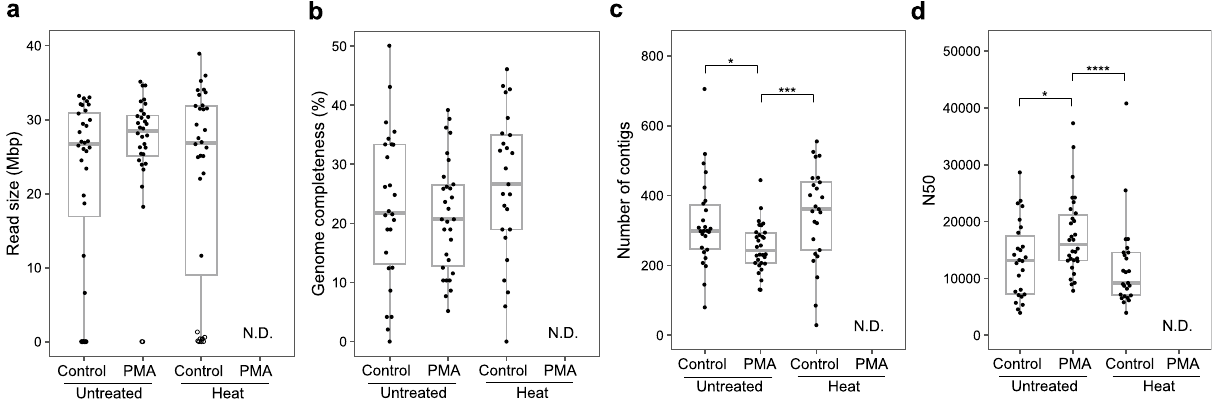
Figure 2. Effect of PMA treatment on single-cell whole-genome sequencing. Untreated and heat-killed E. coli samples were reacted with PMA and processed with SAG-gel for whole-genome sequencing. ( a ) Size of raw sequence reads. An SAG < 1 Mb is indicated by a white circle. ( b ) Genome completeness of SAGs. ( c ) Number of contigs in the SAGs. ( d ) N50 of SAGs. 32 SAGs were sequenced for each sample. In ( b–d ), SAGs with < 1 Mb reads were removed. PMA-heat- E. coli showed no fluorescent gel capsules, so we could not determine their sequencing states (N.D. not determined). Control means no PMA treatment. *p < 0.05; ***p < 0.005; ****p < 0.001 (Wilcoxon rank-sum